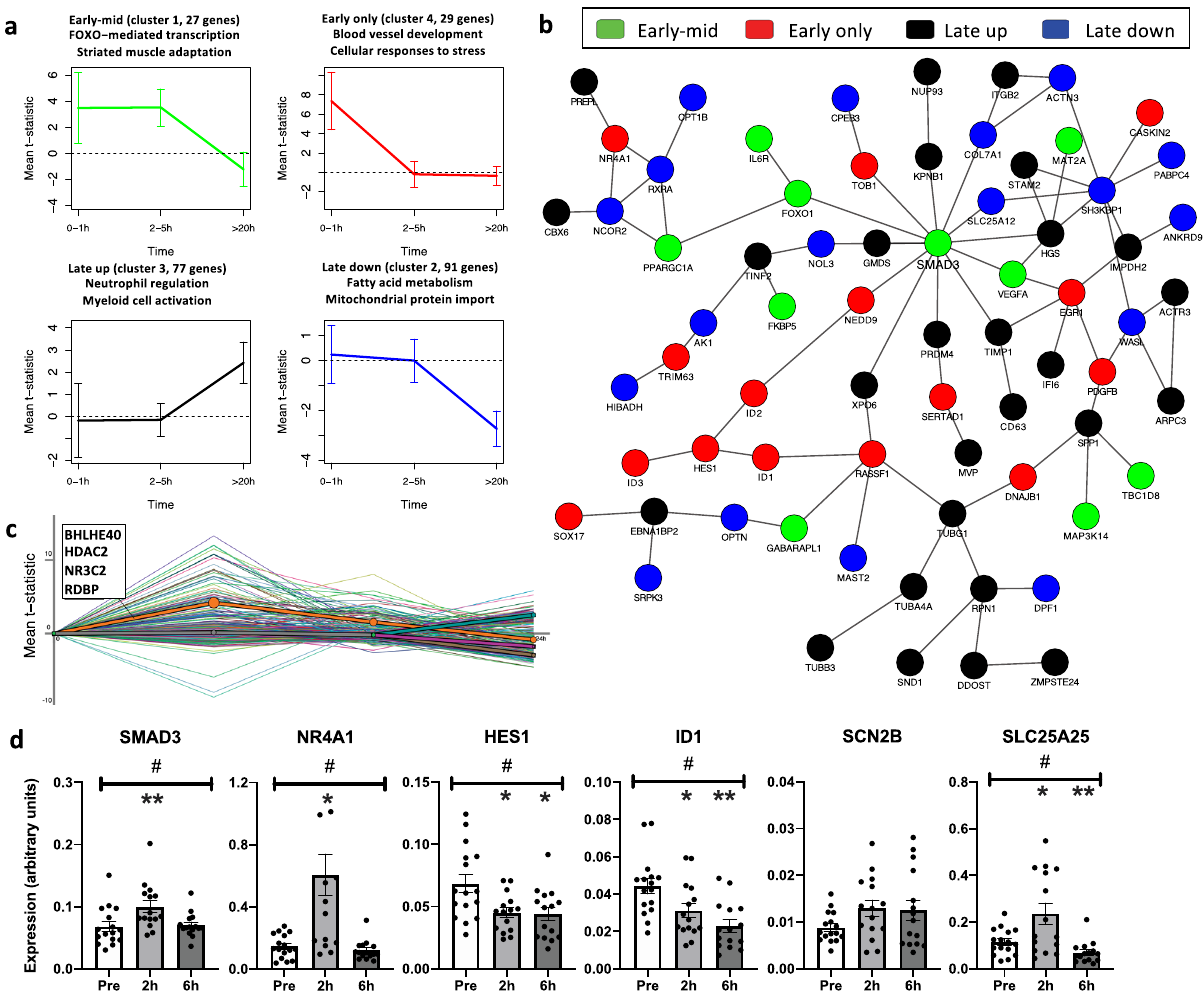
Fig. 4 Differential expression patterns in skeletal muscle after acute exercise. a Genes associated with time were partitioned into four groups based on their trajectories. The title of each subplot shows signi fi cantly enriched Gene Ontology terms or pathways. b The main GeneMANIA connected component of the genes in a when overlaid on known protein – protein or pathway networks. c Dynamic regulatory events miner (DREM) analysis results of the genes in A predict several transcription factors to be involved in the observed responses. d Validation of gene expression changes following acute endurance exercise in a separate human cohort ( n = 16). SMAD3 , NR4A1 , HES1 and ID1 from the acute network and SCN2B and SLC25A25 from the endurance and time-speci fi c genes. Expression levels are calculated relative to the average of two housekeeping genes ( GAPDH and RPS18 ). # denotes an overall signi fi cant treatment effect between time points ( p < 0.05). *( p < 0.05) and **( p < 0.005) denote signi fi cant expression difference compared to before exercise (pre) after correction for multiple comparisons. Values are presented as mean±standard error of the mean. Source data are provided as a Source Data fi